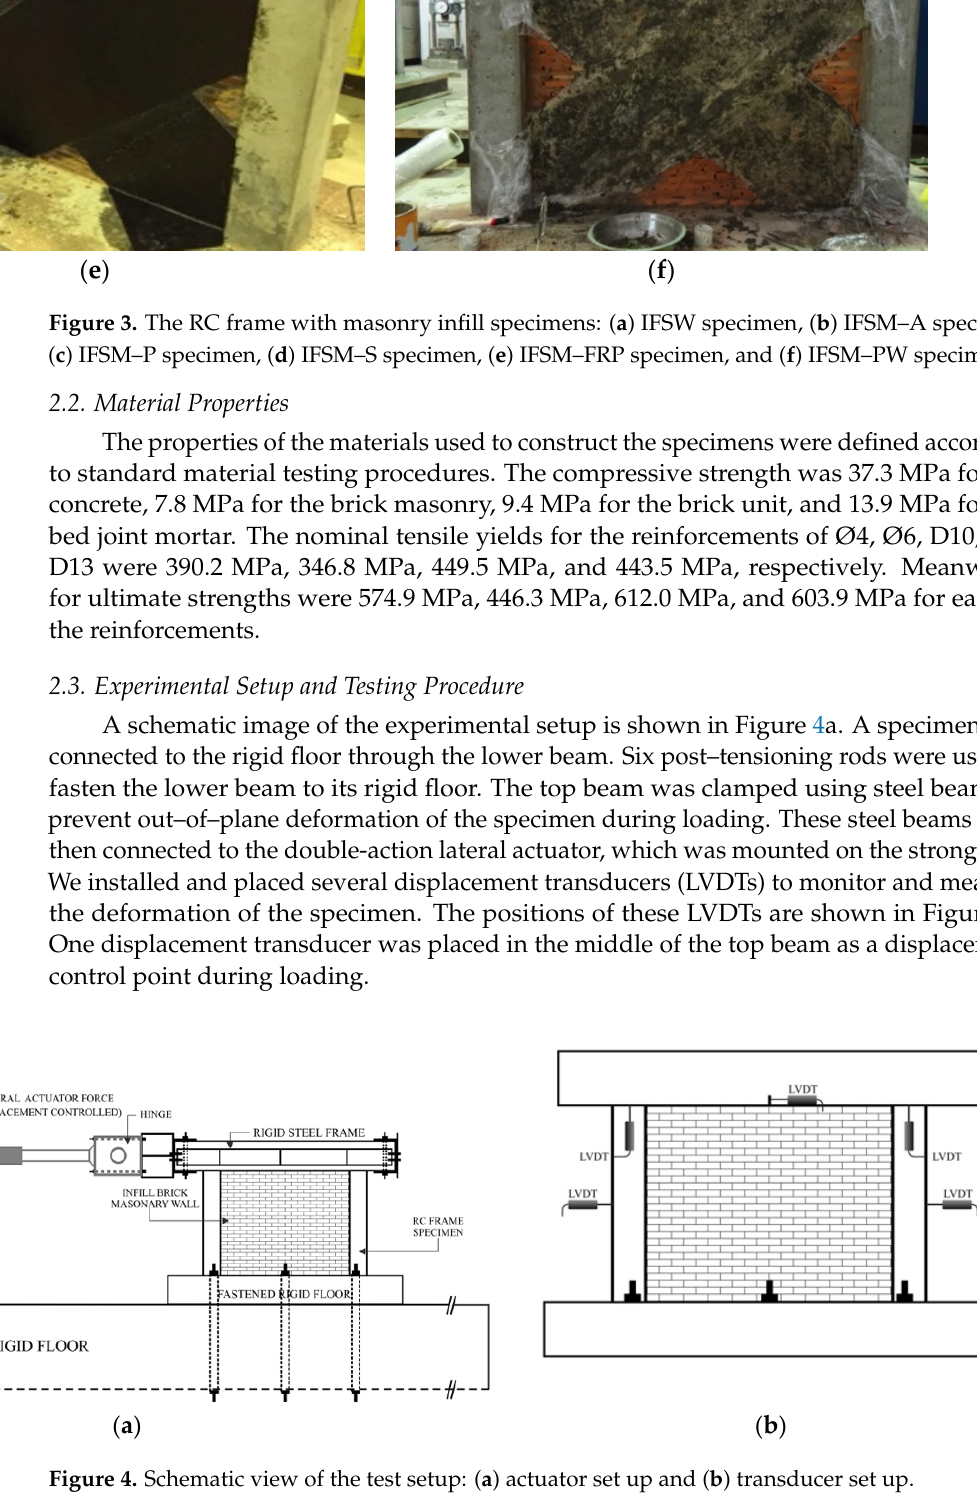
Figure 4. Schematic view of the test setup: ( a ) actuator set up and ( b ) transducer set up.